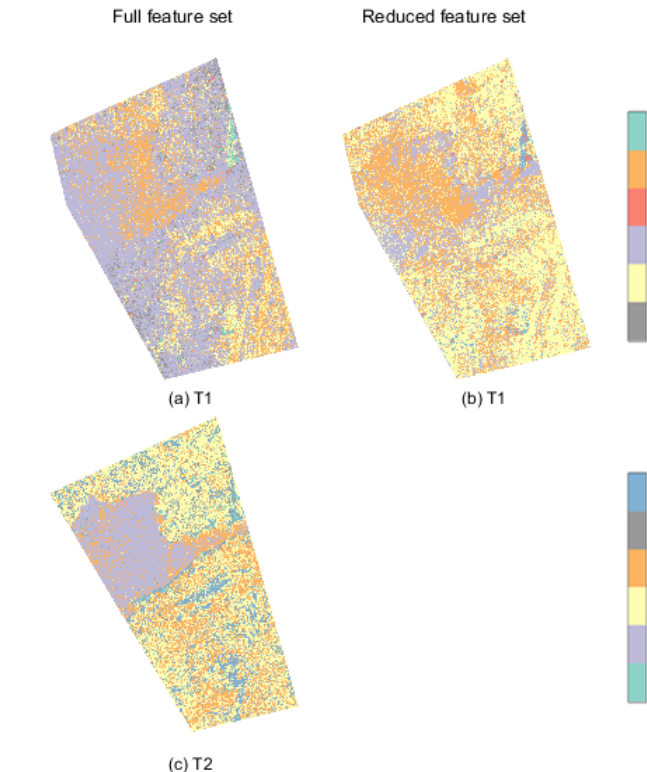
Figure 10. Segmentations of the two TerraSAR-X scenes (T1 and T2) into six segments. To the left: segmentation with full achiev- able feature set. For T1 the feature set consists of relative kurtosis, geometric brightness, co-polarisation ratio, co-polarisation correla- tion magnitude and co-polarisation correlation angle. For T2 the feature set consists of relative kurtosis, geometric brightness and cross-polarisation ratio. To the right: segmentation of T1 with the reduced feature set consisting of relative kurtosis, geometric bright- ness and co-polarisation correlation